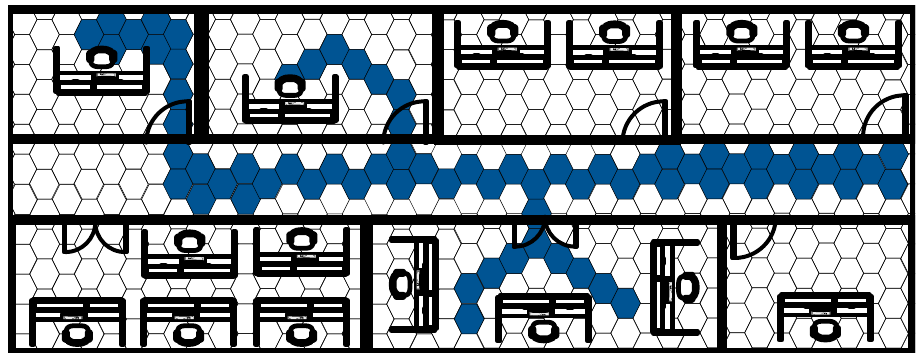
Figure 10. Simultaneous localization and